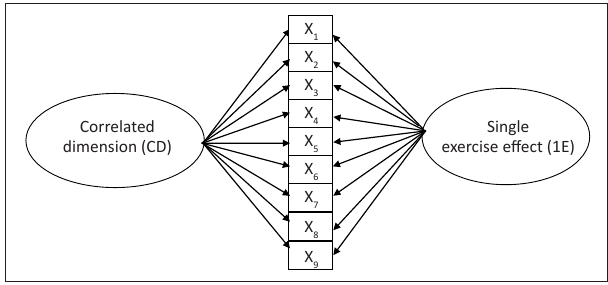
FIGURE 1: Leadership skills (1D1E model).